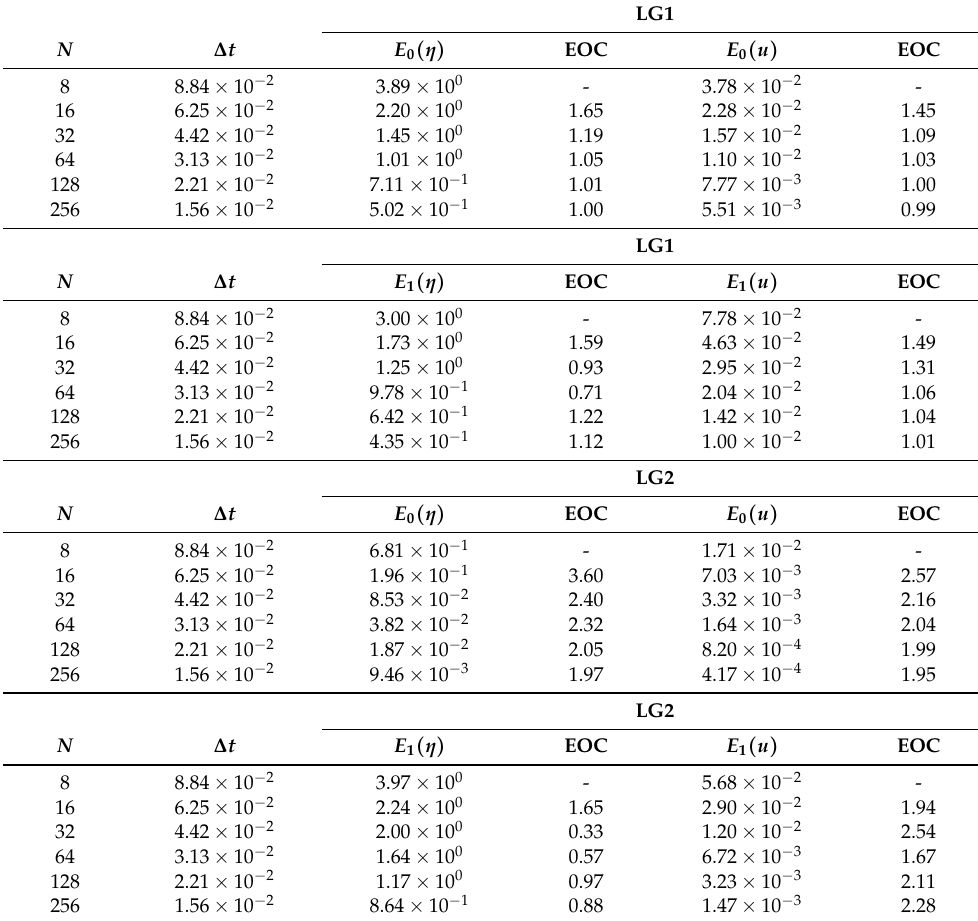
Figure 5. Graphs of errors E 1 ( η ) and E 1 ( u ) in logarithmic scale by LG1 for Example 1 ( i ) and Example 2 ( ii ), and by LG2 for Example 1 ( iii ) and Example 2 ( iv ). Table 1. Values of E i ( η ) and E i ( u ) , i = 0,1, by schemes LG1 and LG2 for Example 1 ( Γ = Γ D